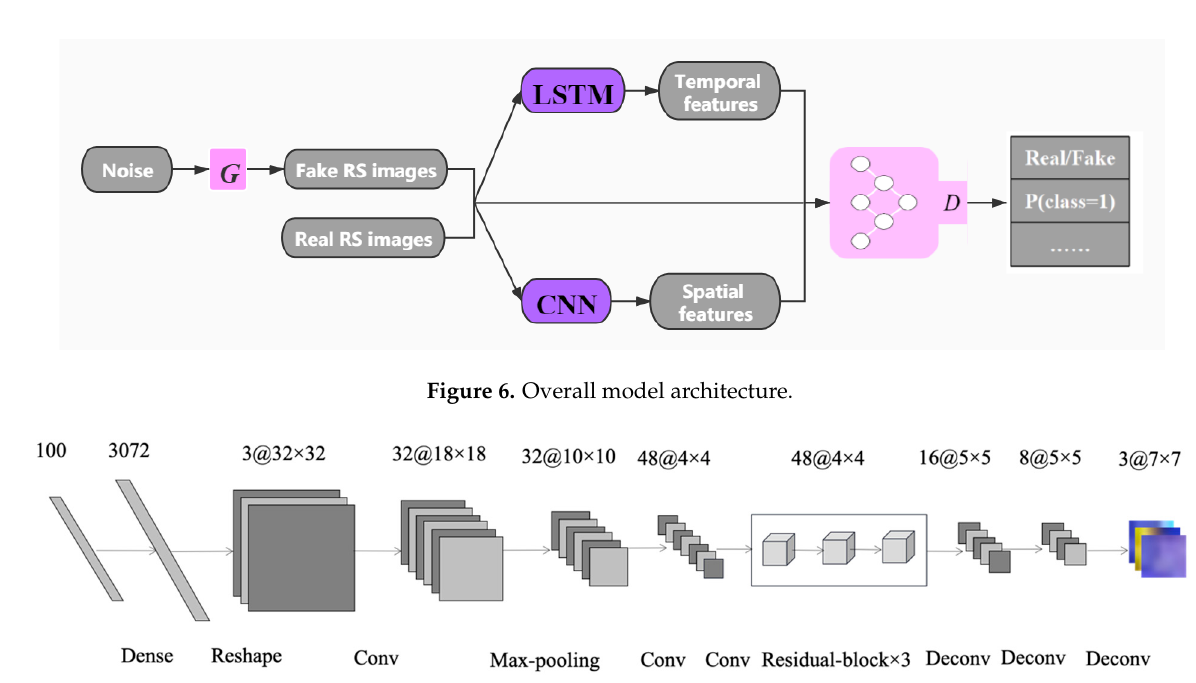
Figure 7. The generator architecture.